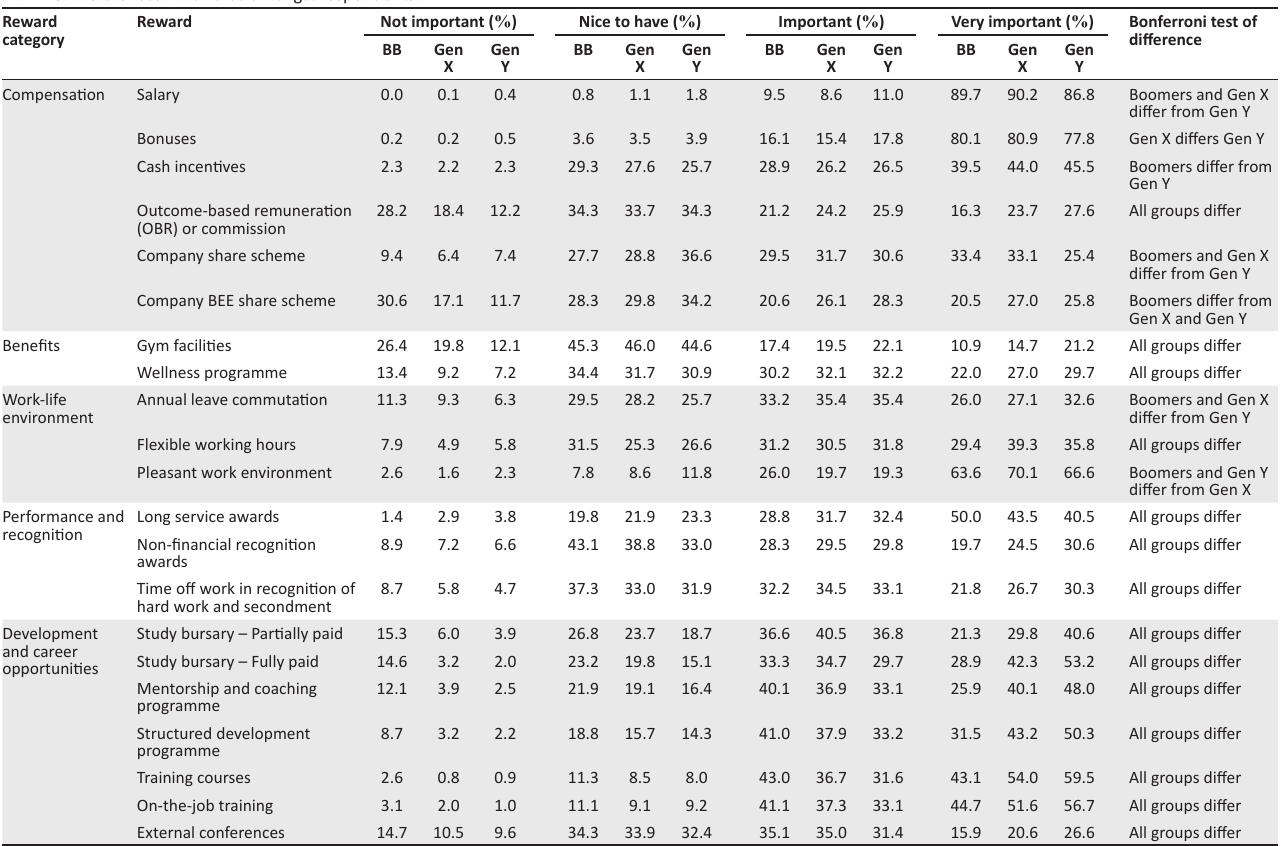
TABLE 6: Preferences in rewards amongst respondents.